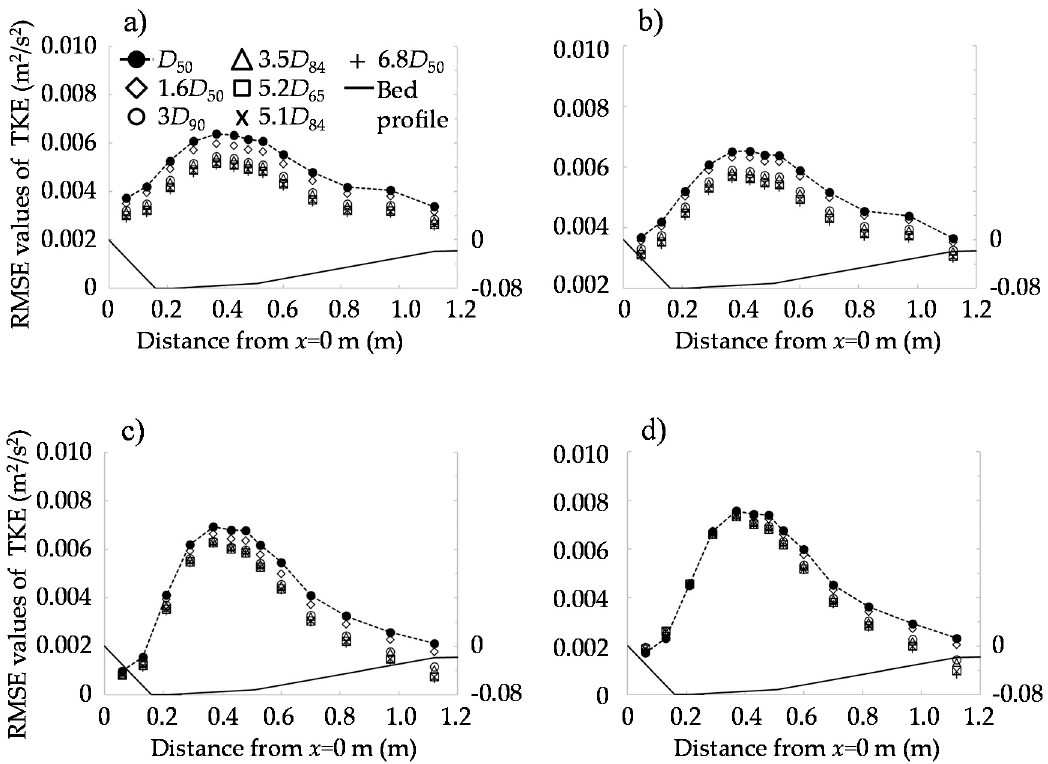
Figure 8. RMSE of TKE with various bottom roughness height formulas: ( a ) Fully depth-averaged (0 < z / h 0 < 1) RMSE with k- ε model; ( b ) Fully depth-averaged with k- ω SST model; ( c ) Partially depth-averaged (0 < z / h 0 < 0.15) k- ε model for the lower part; ( d ) Partially depth-averaged (0 < z / h 0 < 0.15) k- ω SST model.